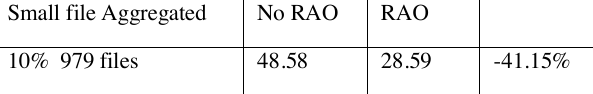
Table 9 Random Spacing, RAO effects for 1 GB Aggregated